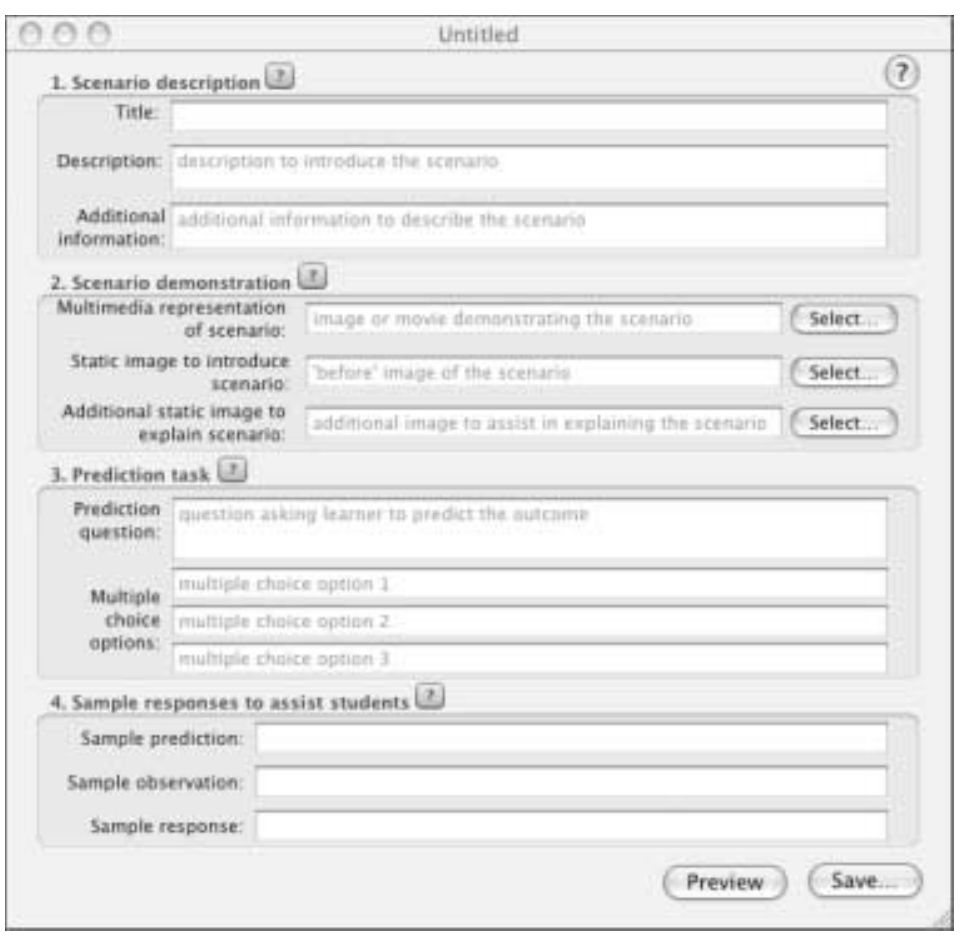
Figure 6. Example of pedagogical support provided by the UOS Editor when designing a POE UOS